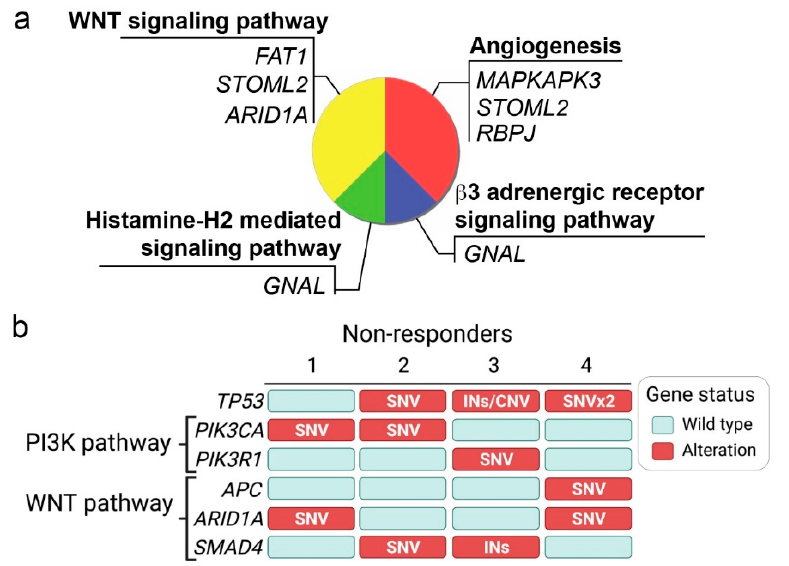
Figure 2. Enriched pathways in non-responders to chemo-immunotherapy. ( a ) Cell signaling path- way enrichment analyses were performed by obtaining gene lists of differentially expressed genes.